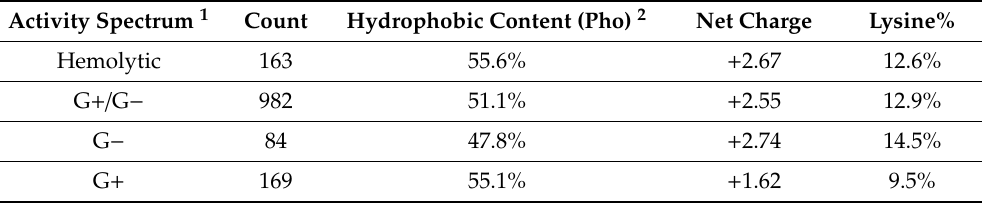
Table 3. Di ff erent requirements of amphibian peptides for antibacterial and hemolytic